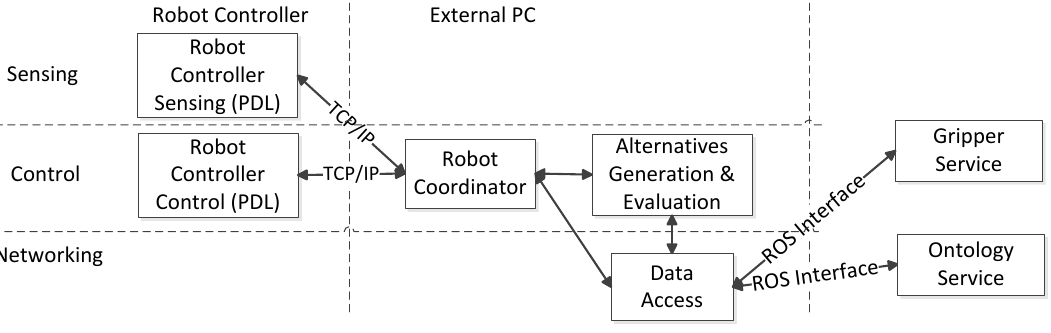
Figure 3. Robot agent architecture.